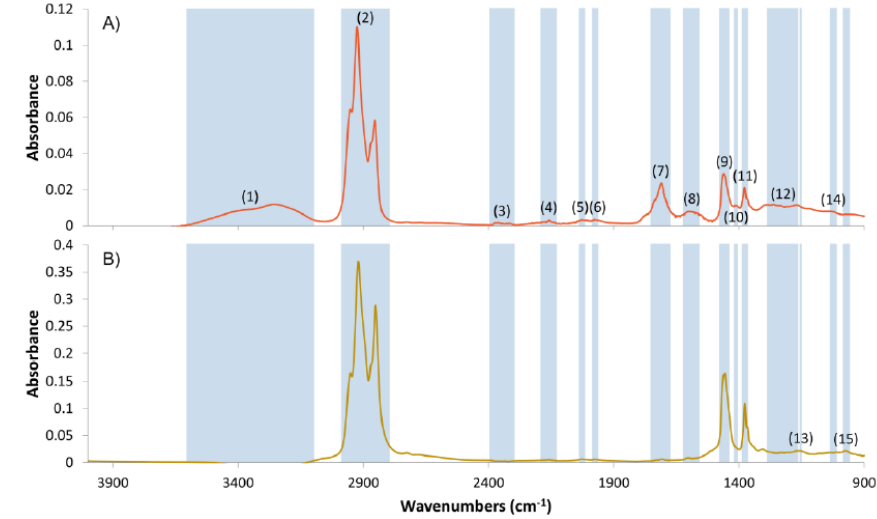
Figure 2. Fourier transform infrared spectroscopy (FTIR) spectra of MK8 lubricant oil: ( A ) spent ULO and ( B ) fresh LO. Absorbance bands: (1) O-H stretching in alcohols; (2) C-H stretching in hydrocarbons; (3) NH 2 + deformation and NH + stretching in amines; (4) Si-H stretching; (5) N = C = S stretching in isothiocyanates; (6) C-H bending in aromatics; (7) C = O stretching in esters, ketones and carboxylic acids; (8) C-C stretching in aromatic rings; (9) C-H bending in hydrocarbons; (10) S = O stretching in sulfates and sulfonates; (11) C-H branching vibration in hydrocarbons; (12) C-O-C stretching in esters and ethers; (13) sulfonate salts, methacrylates; (14) C-N stretching in amines; (15) P-O-C and P = S bonds in zinc dialkyl dithiophosphates